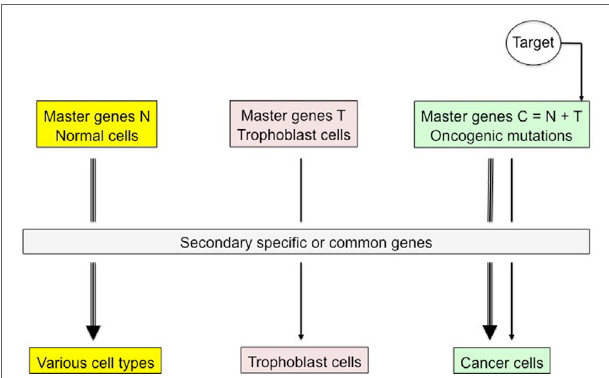
FigUre 4 | Specific therapeutic targeting of trophoblastic master genes. Trophoblastic transdifferentiation is supposed to promote active malignancy in mutated, precancerous cells. Blocking expression of trophoblastic master genes or of related transcription factors and cell biomarkers would exclusively have an impact on cancer cells, thus jeopardizing the tumor with a priori no consequence on normal somatic cells where trophoblastic genes are tightly locked. For instance, immunological targeting of tumor trophoblastic components could be a good therapeutic